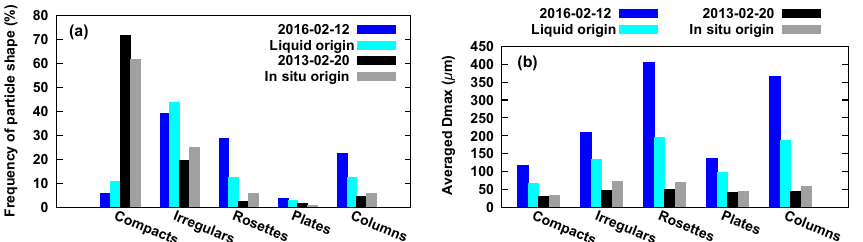
Figure 9. Occurrence of different particle shapes depending on cloud origin (a) and average D max for the different shapes (b) . Mean values of shape and size of the four in situ origin (grey) measurements and four liquid origin (light blue) measurements. Mean values of shape and size of one in situ origin measurement day (black) and of one liquid origin measurement day (blue).